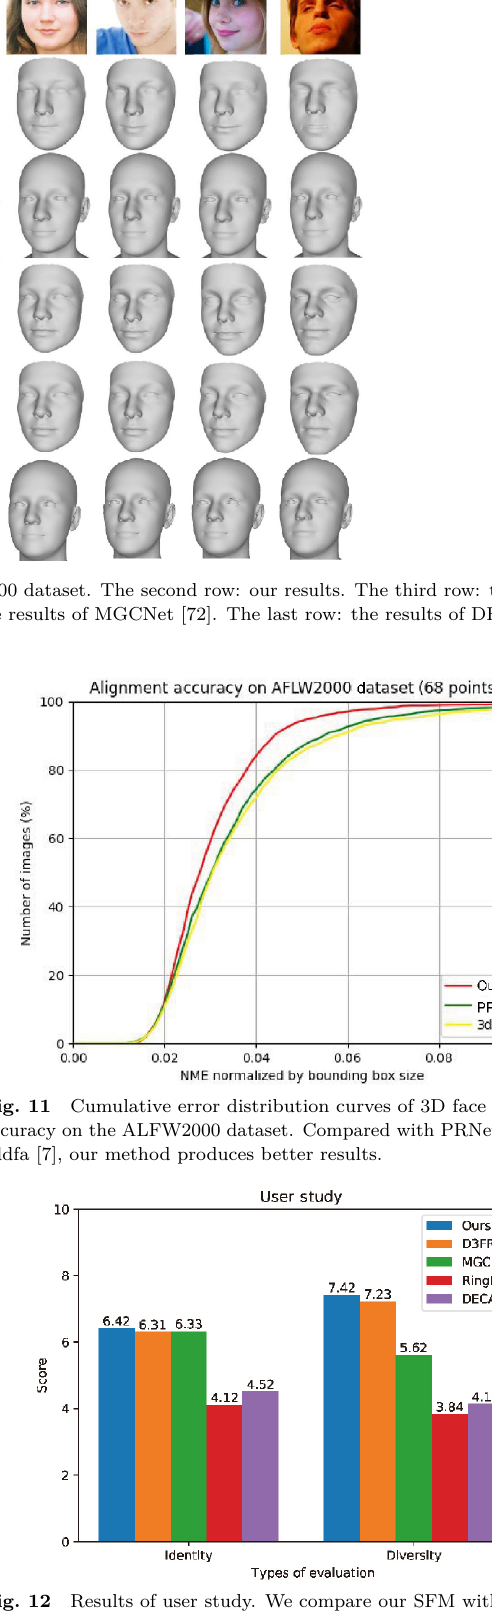
Fig. 12 Results of user study. We compare our SFM with RingNet [9], D3FR [34], MGCNet [72], and DECA [41] in terms of identity and diversity, and our results are more